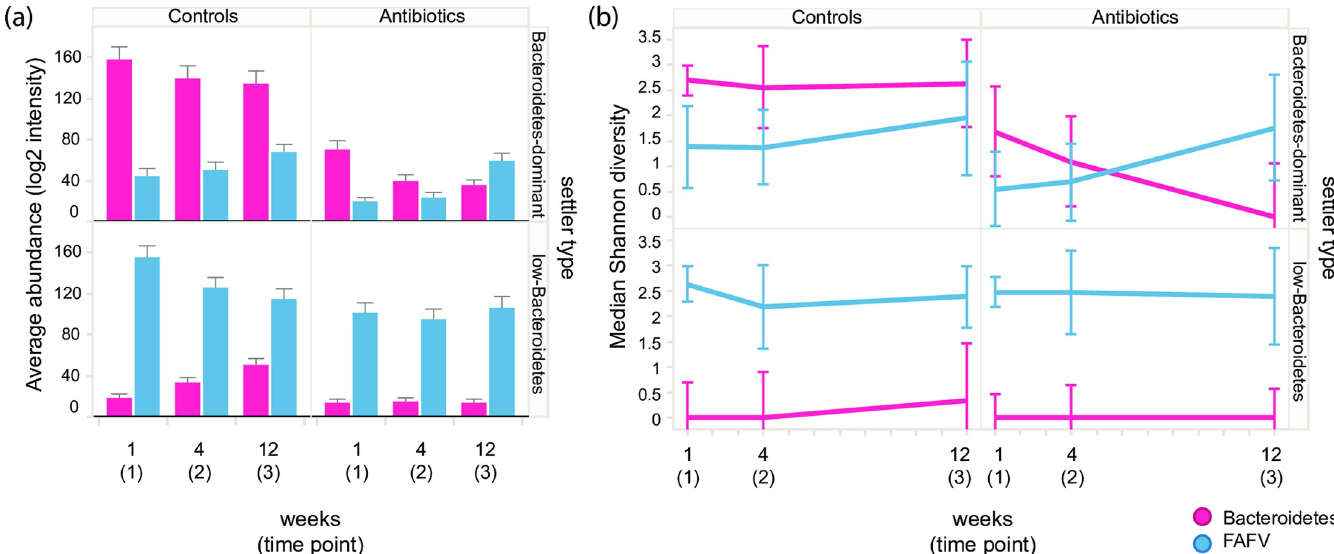
Fig 3. Abundance and diversity of Bacteroidetes and FAFV by settler type and treatment group. (a) Average abundance of Bacteroidetes and FAFV over time by settler type (rows) and treatment group (columns). Values are log2 transformed intensities (measured as log2 RFU). Error bars depict the standard error. (b) Median Shannon diversity index of Bacteroidetes and FAFV over time by settler type (rows) and treatment group (columns). Error bars denote the upper and lower IQR (inter quartile range); RFU—relative fluorescent units; FAFV = Firmicutes, Actinobacteria, Fusobacteria, Verrucomicrobia.